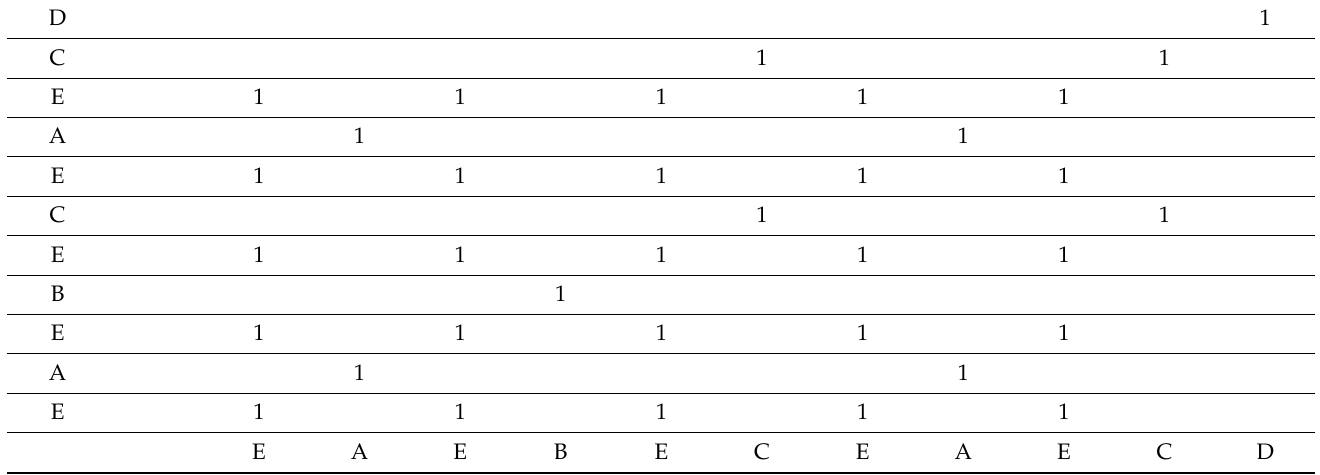
Figure 2 .Binary image for the map (3) with n = 10. Table 1. Correlation